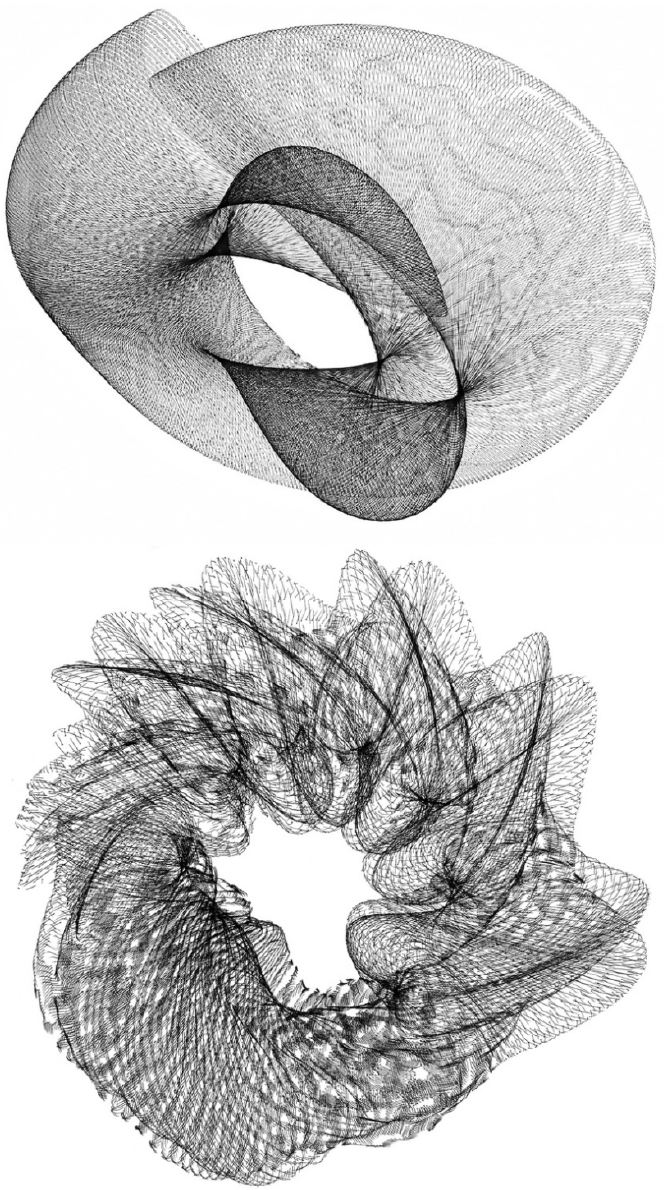
Figure 1. Drawings showing near chaotic secondary patterns from the selected machines.